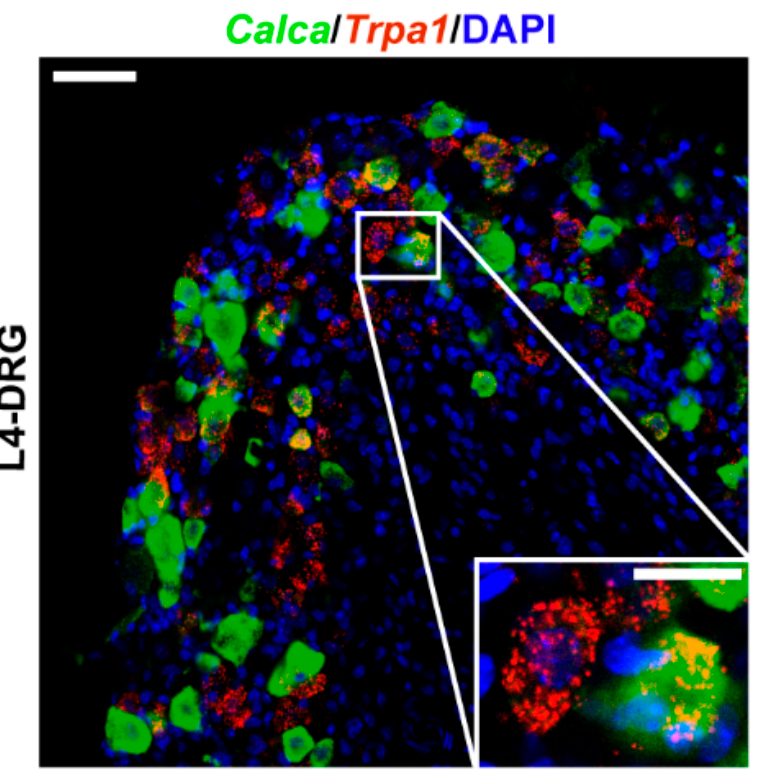
Figure 1. Confocal image of Trpa1 mRNA expression on dorsal root ganglion (DRG). Trpa1 (red) and Calca (CGRP, green) mRNA expression counterstained with DAPI are shown in mouse L4-DRG. Scale bar: 50 µm, inset scale bar: 20 µm.